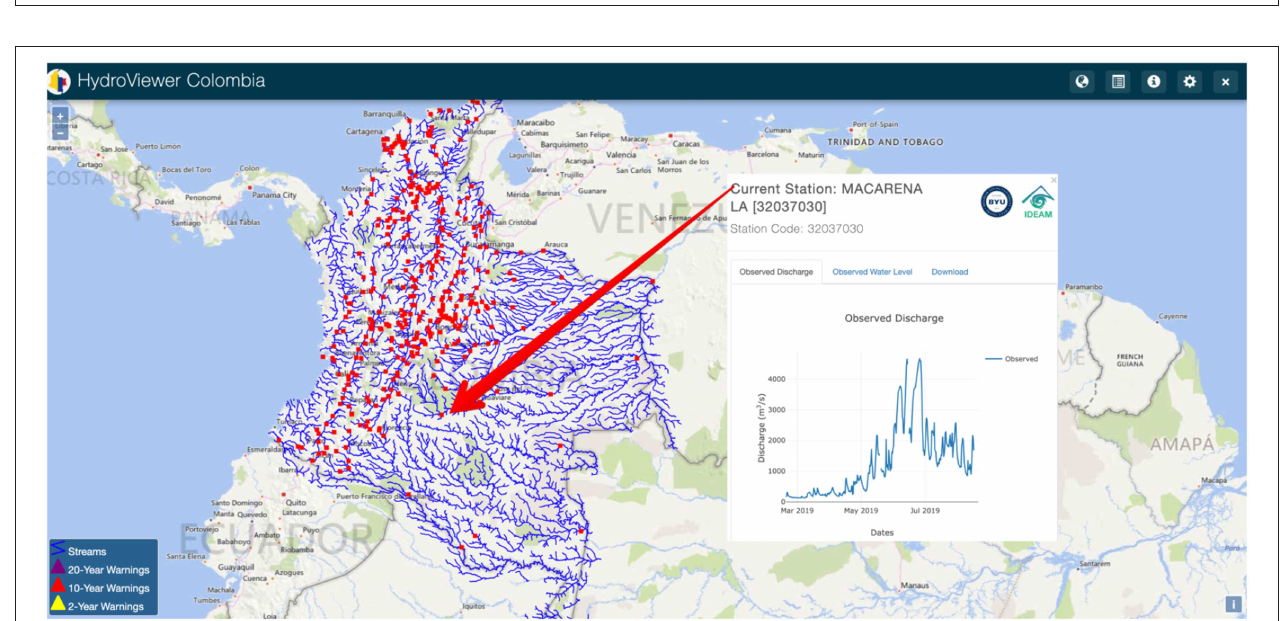
FIGURE 8 | Hydroviewer Colombia displaying observed data